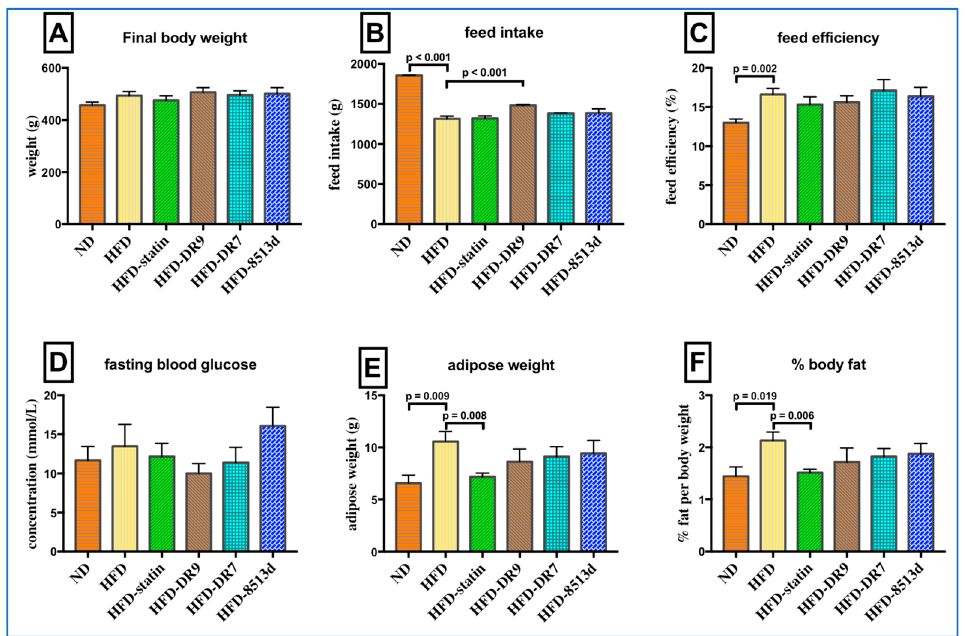
Figure 1. Final body weight ( A ), feed intake ( B ), feed e ffi ciency ( C ), fasting blood glucose ( D ), adipose weight ( E ), and percent body fat ( F ) in D-galactose-induced aging rats (600 mg / kg / day) after 12 weeks of treatment. ND (normal diet), HFD (high-fat diet), HFD-statin (high-fat diet, receiving lovastatin 2 mg / kg / day), HFD-DR9 (high-fat diet, receiving L. fermentum DR9 (10 10 CFU / day), HFD-DR7 (high-fat diet, receiving L. plantarum DR7 (10 10 CFU / day), HFD-8513d (high-fat diet, receiving L. reuteri 8513d (10 10 CFU / day). Results are expressed as mean; error bars (SEM); n = 6. Results are expressed as mean; error bars (SEM); n = 6. Statistical analysis was performed using independent t -tests. * Food e ffi ciency, weight gain (g) / feed intake (g) × 100.